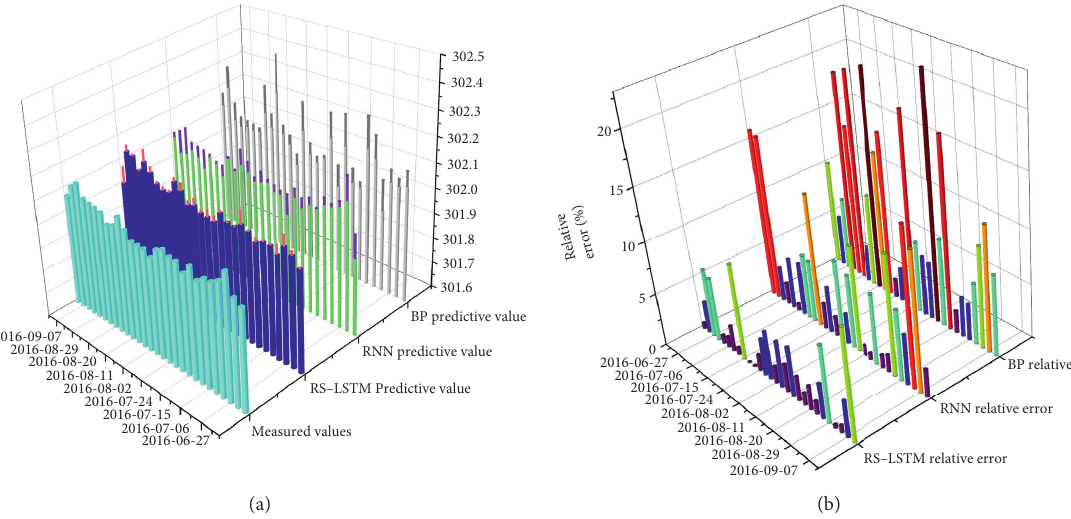
Figure 8: Comparison between prediction and measurement of different models. (a) Comparison diagram of the seepage pressure of each model. (b) Relative error comparison diagram.